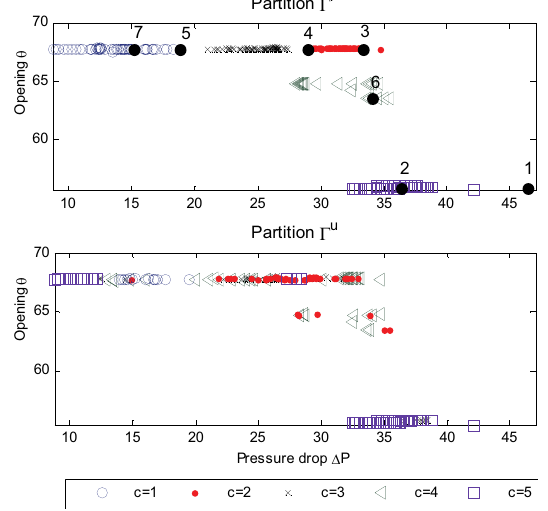
Fig. 4. Visualization on the space S r = (cid:507) P× (cid:537) of the patterns assigned to the five clusters in (cid:299) r (top) and (cid:299) u (bottom). In the top graph, the WT patterns are also shown (black dots, numbered in chronological